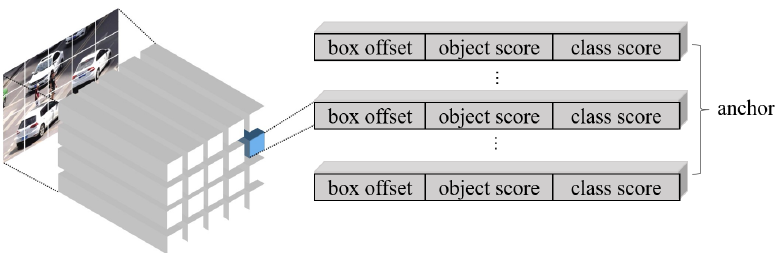
Figure 2. Structure of the single-stage object detection output tensor.